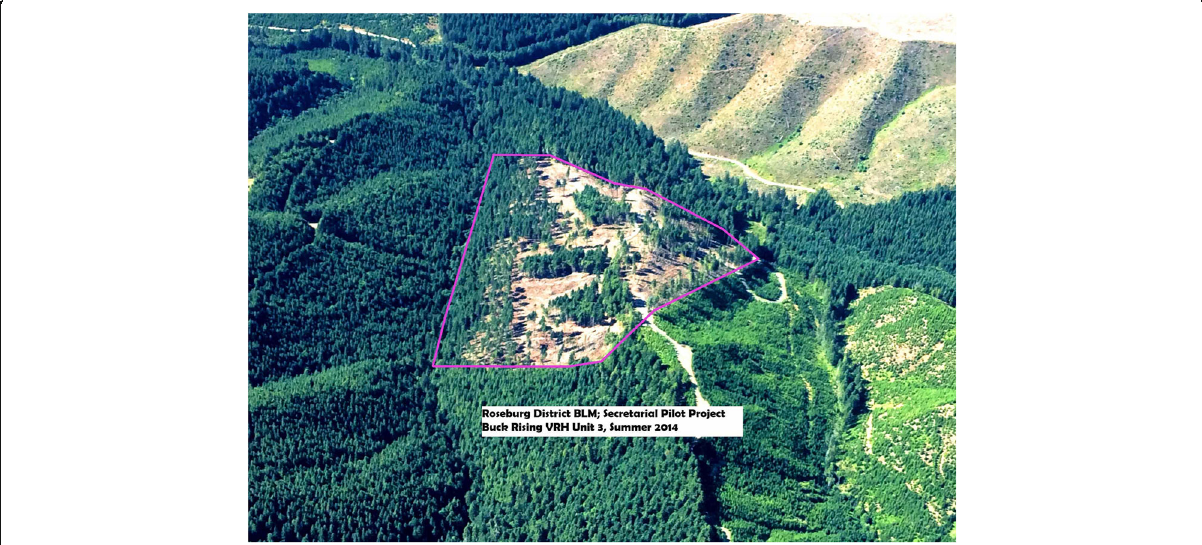
Fig. 5 The US Bureau of Land Management is making extensive use of innovative retention harvesting treatments in the management of ~ 1 million hectares of the forest in western Oregon; illustrated here is an aerial view of retention in a 50-year-old plantation. Note the lack of any kinds of legacies in the adjacent private forestlands (upper right of picture) that are managed for maximizing return-on-capital. All regeneration harvesting conducted by BLM on these lands is by variable-retention